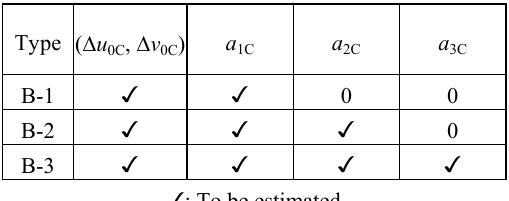
 : To be estimated Table 2. Coefficients in the correction function of the Types B-1 to